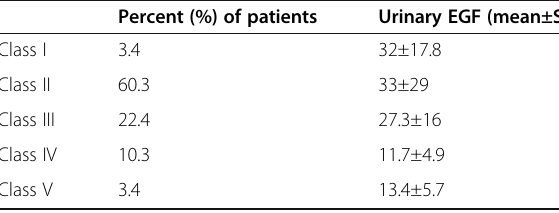
Table 3 Histological classification of renal biopsy Percent (%) of